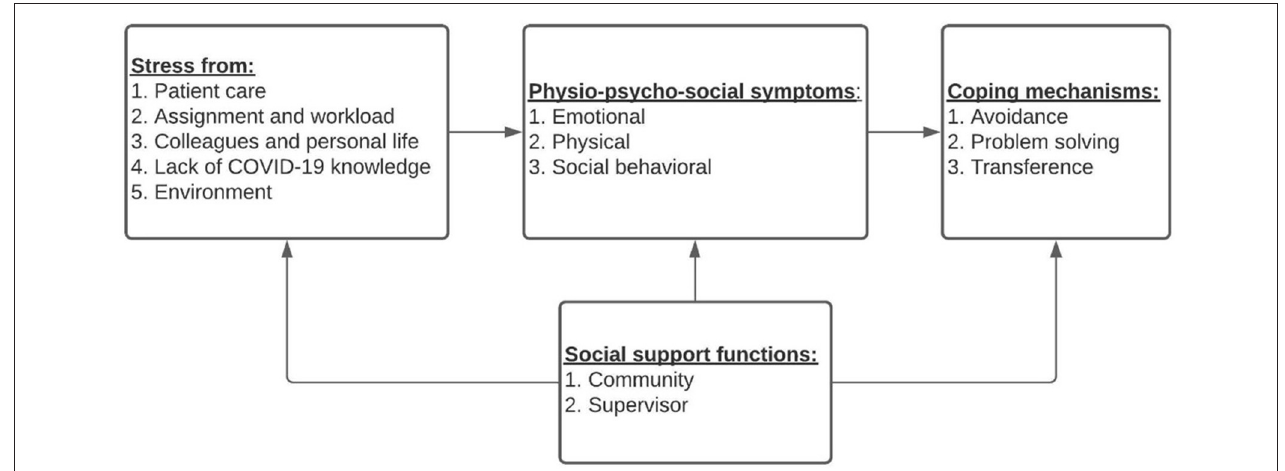
FIGURE 1 | Stress-symptom-support-coping framework for frontline nurses during the COVID-19 pandemic.